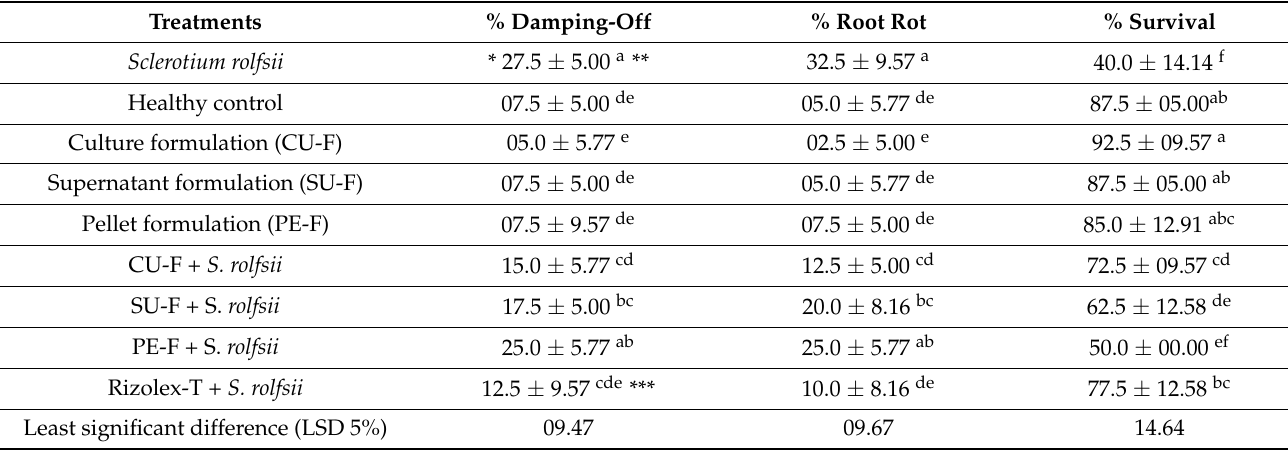
Figure 7. Effect of talc-based culture, supernatant, and pellet formulations of Streptomyces cellulosae Actino 48 as biofungicides on peanut root rot and pod rot diseases compared with Rizolex-T as the recommended fungicide under artificial infection and greenhouse conditions. Table 2. Effect of treatment with talc-based formulations of Streptomyces cellulosa Actino 48 on peanut damping-off and root rot incidence (%) under artificial infection and greenhouse conditions.